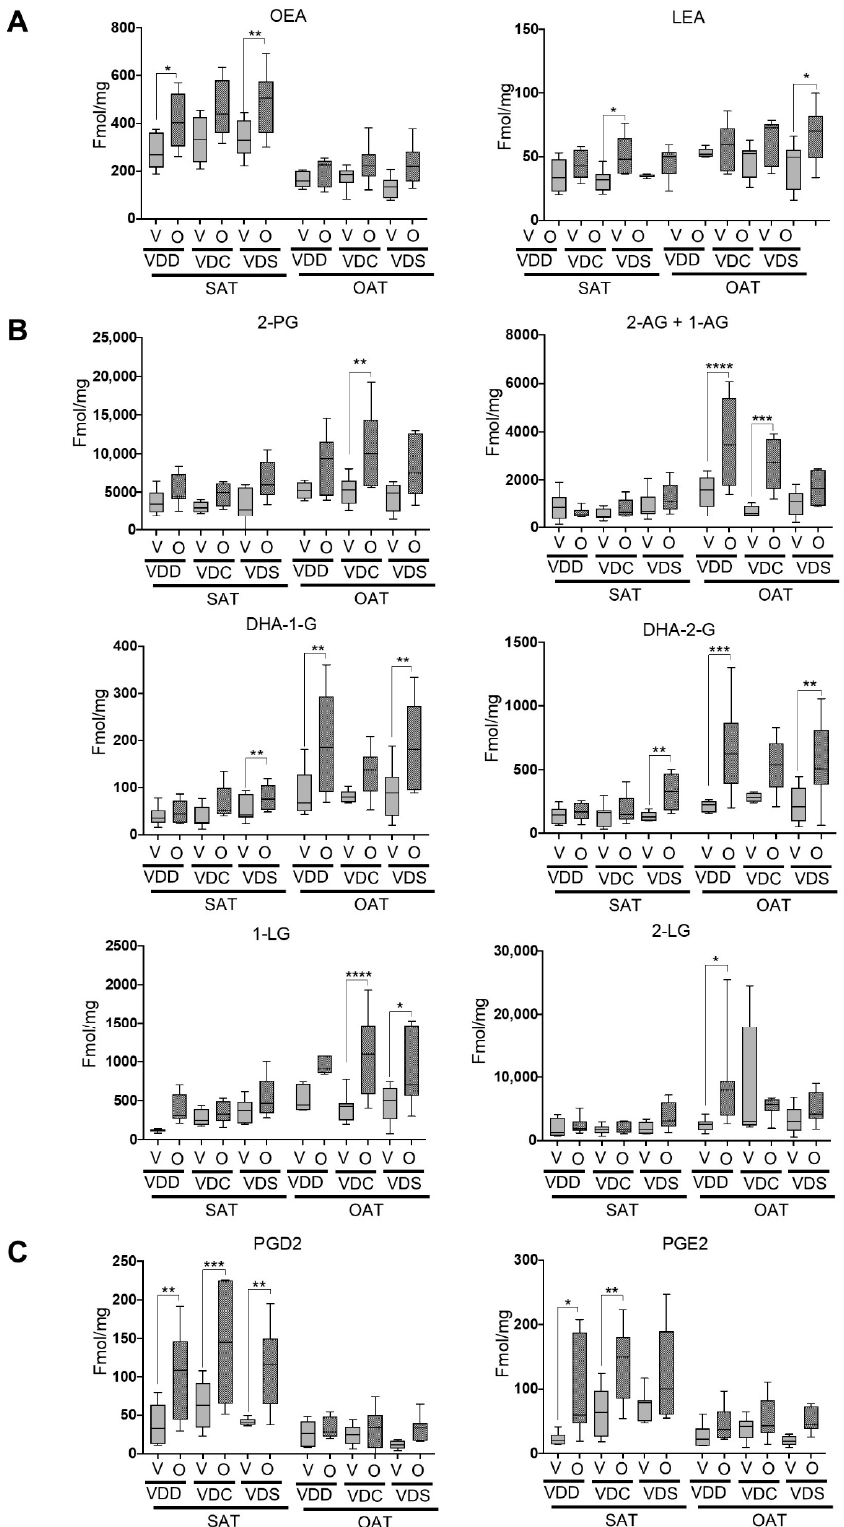
Figure 4. Concentrations of eCBome selected congeners in subcutaneous (SAT) and ovarian (OAT) adipose tissues. Levels of ( A ) NAEs, ( B ) 2-MAGs and ( C ) prostaglandins are expressed as pmol/mg of tissue. Data are shown as box (5th and 95th and mean value) and whisker (minimum and maximum values) plots. * p ≤ 0.05; ** p ≤ 0.01; *** p ≤ 0.005; **** p ≤ 0.001. VDD, Vitamin D deficiency; VDC, Vitamin D control; VDS, Vitamin D supplemented; O, Olanzapine; V, Vehicle; SAT, Subcutaneous adipose tissue; OAT, Ovarian adipose